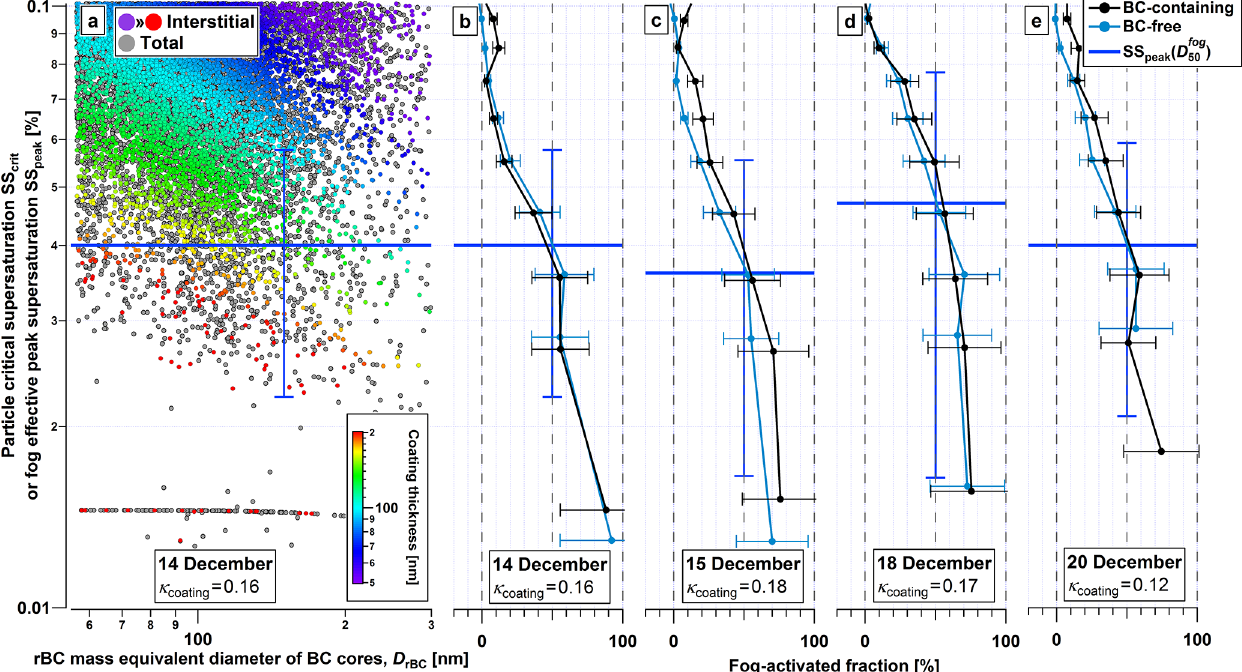
Figure 9. (a) SS crit of individual particles sampled behind the total inlet (grey dots) and interstitial inlet (dots coloured by (cid:49) coating ) as a function of their D rBC during the 14 December fog event. The distinct band of data points appearing with an SS crit of 0.015% corresponds to BC-containing particles which caused saturation of the scattering detector even in the leading edge range of the signal, making it impossible to accurately determine SS crit . As these particles are known to have lower SS crit than the most thickly coated particles which did not cause signal saturation, they are assigned a “randomly chosen” low value for SS crit and included in the figure. (b) , (c) , (d) , (e) Fog-activated fractions of BC-containing (black lines) and BC-free (light blue lines) particles per class of 0.01% SS for the 14, 15, 18 and 20 December fog events, respectively. The horizontal error bars associated with the activated fractions represent Poisson-based statistical uncertainties. The horizontal blue lines show the SS peak for each fog event retrieved using D fog (with the method and uncertainty explained in Sect. 2.3.5). 50 ( (cid:49) SS crit = 0 . 01 %) and averaged over all core sizes.